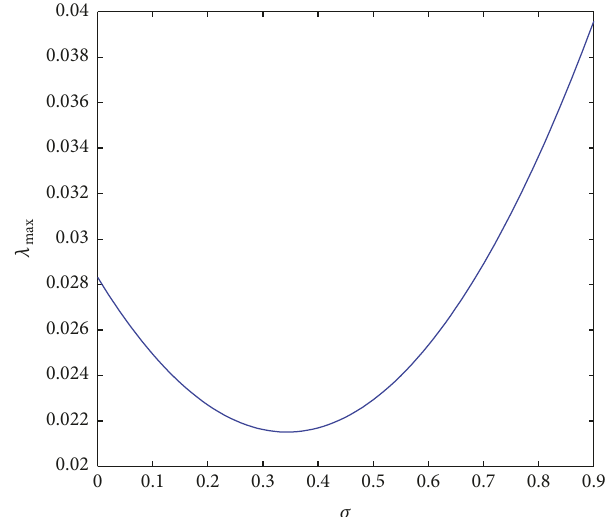
Figure 7: The maximal Lyapunov exponent in quadratic coupling case in (5a)–(5h). The parameter is fixed as 𝛼 = 0.1